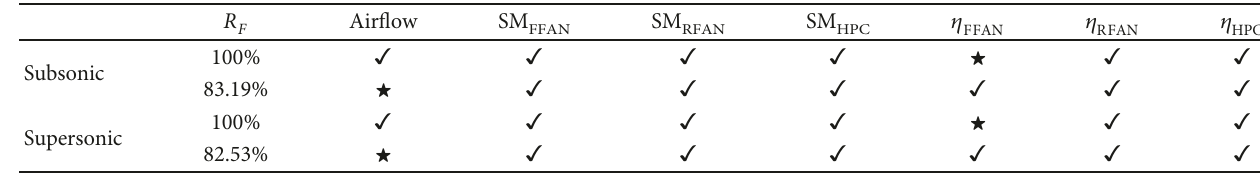
Table 5: Important parameter during throttling (group 1).